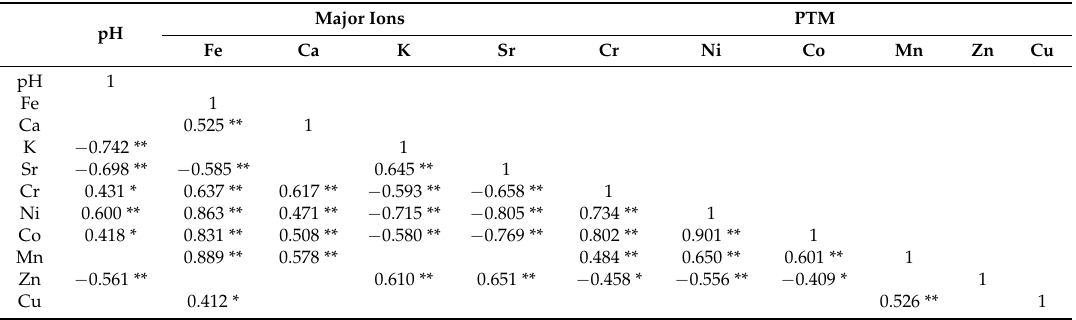
Table 3. Pearson correlation matrix between pH, major ions and potential toxic metals (PTM) in the 6 sub-units of